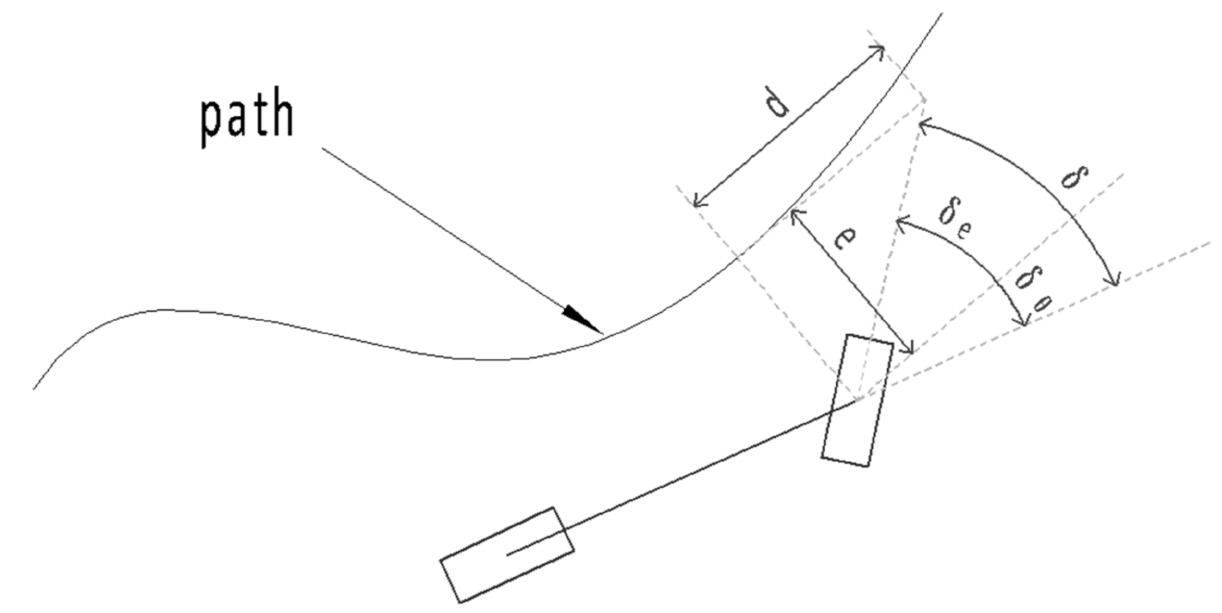
Figure 2. Schematic diagram of Stanley